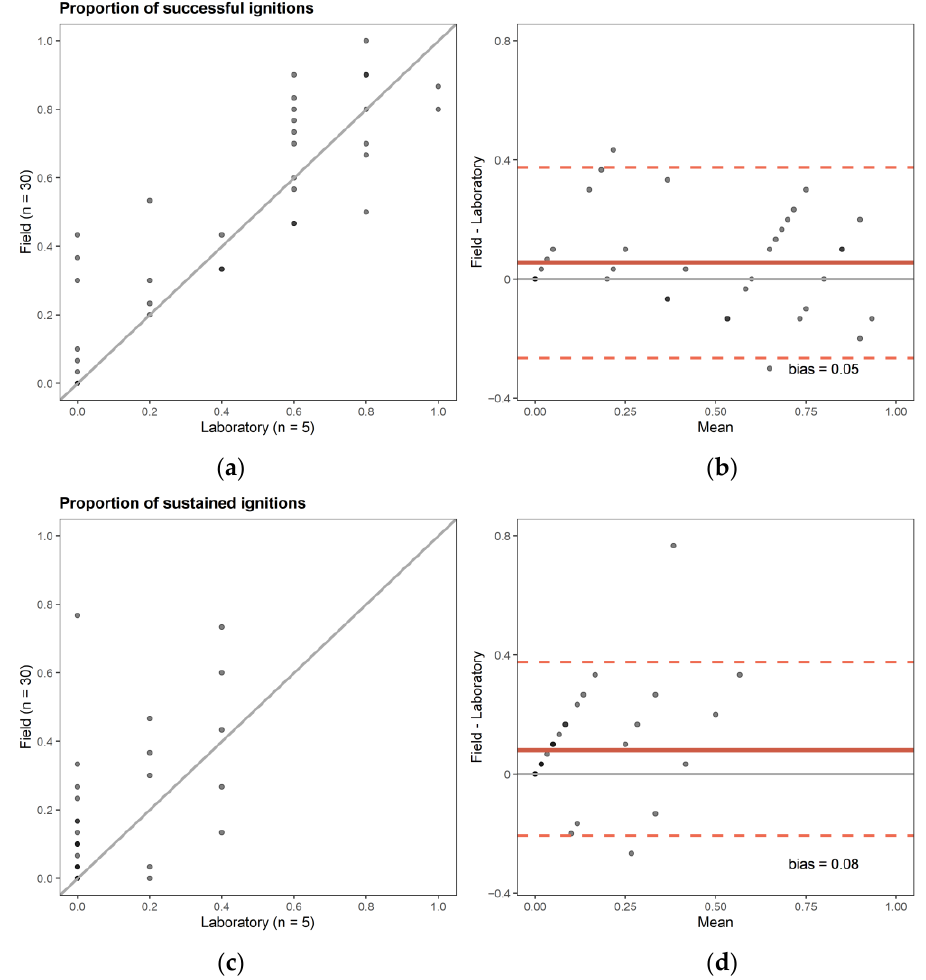
Figure 4. Comparing ignition measured in the field and the laboratory: ( a ) laboratory vs. field successful ignition; ( b ) Bland–Altman plot for successful ignition; ( c ) laboratory vs. field sustained ignition; ( d ) Bland–Altman plot for sustained ignition. The solid red line represents the mean difference between the laboratory and field results. The dashed red line represents the agreement interval, calculated as 1.96 × SD. The solid grey line represents the line of agreement (difference = 0). Table 1. Similarity between the laboratory and field results by site and all sites pooled. Number of plots belonging to each category, followed by percentage of total in parentheses for all